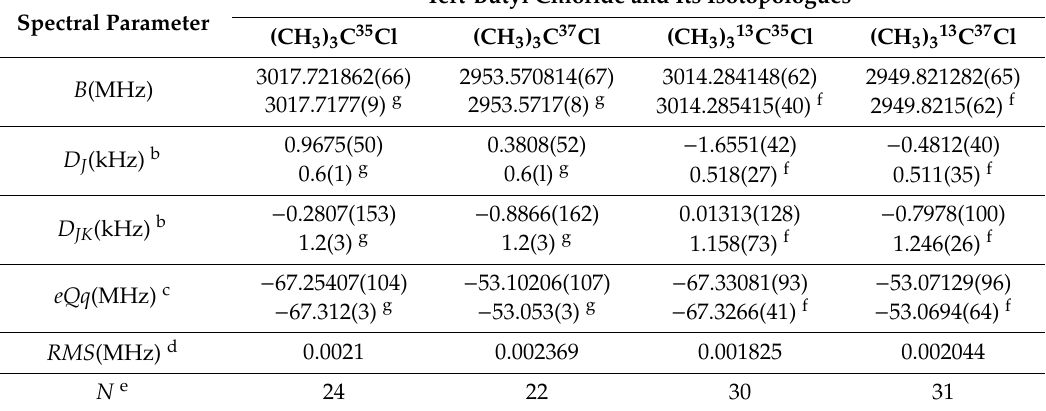
Table 2. Spectral parameters of (CH 3 ) 3 C 35,37 Cl and (CH 3 ) 313 C 35,37 Cl obtained in this work a and relevant values in the